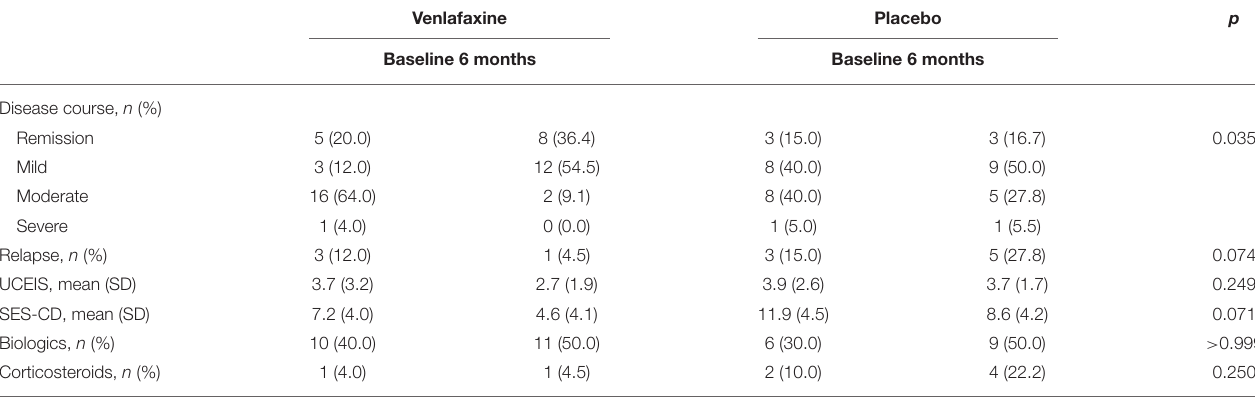
TABLE 5 | Disease course, relapse rate, endoscopic scores, and use rate of biologics and corticosteroids in patients with IBD, randomized to venlafaxine group or placebo group assessed at baseline and 6 months.